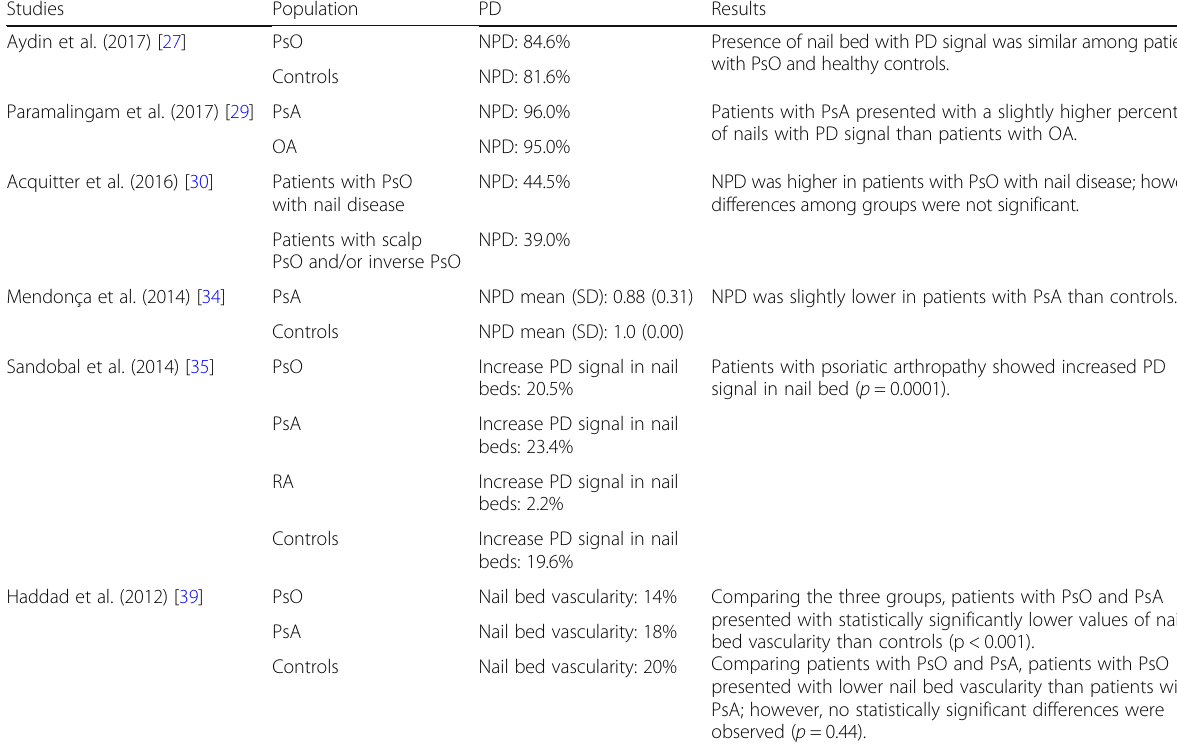
Table 4 Studies comprising quantitative results on PD a Studies